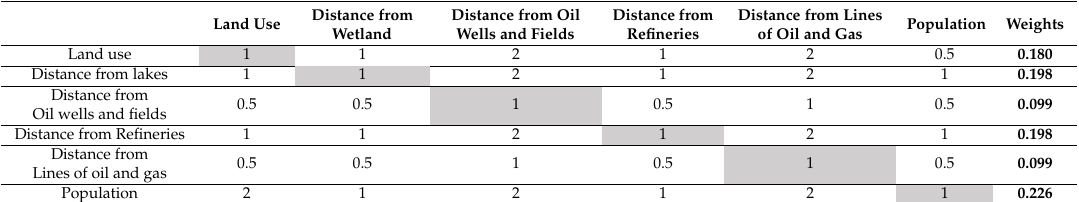
Table 12. Comparison matrix and significance weight of sub- criteria of operational.